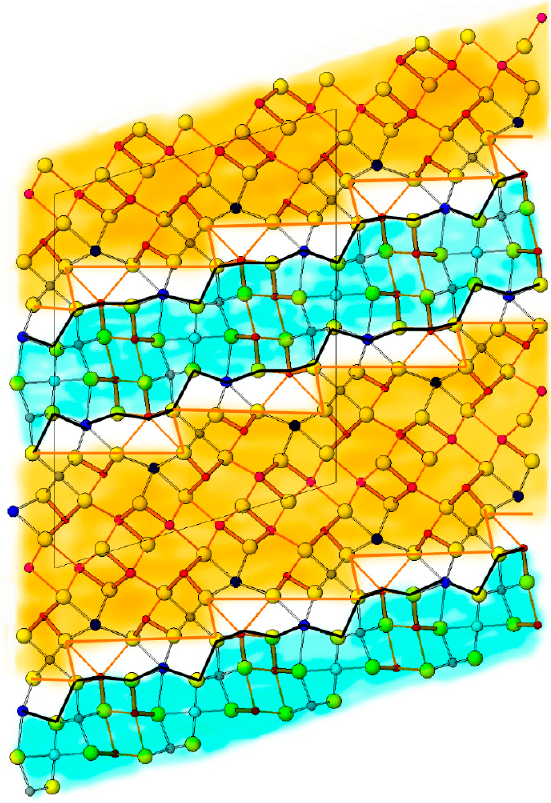
Figure 4. The crystal structure of tsygankoite in terms of mercury containing layers with PbS topology (blue) alternating with Sb-rich layers with SnS-like topology (orange). For atom species see Figure 3. Unit cell edges outlined in black solid line.